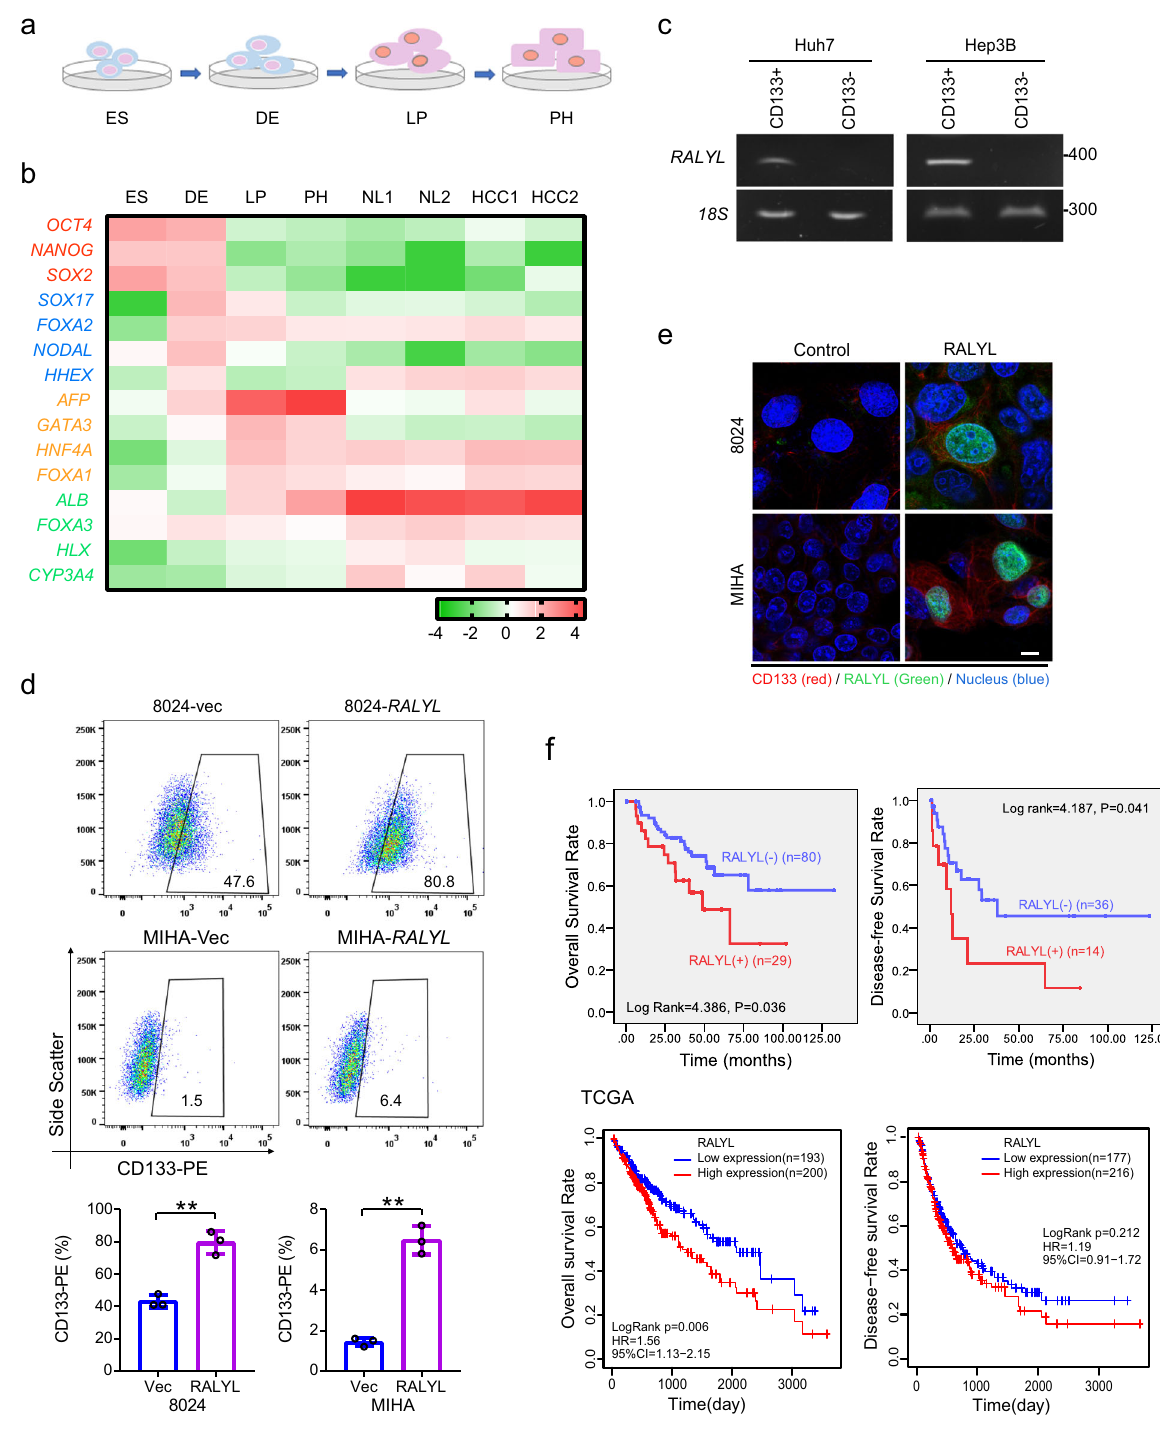
Fig. 1 RALYL selection and clinical signi fi cance. a An in vitro hepatocyte differentiation model, which induced human embryonic stem (ES) cells into de fi nitive endoderm (DE), liver progenitor cells (LP) and premature hepatocytes (PH) step by step, was established. Two HCC samples and two normal liver tissues (NL) were also used to perform the transcriptome sequencing. b Heatmap of expression pro fi les for the speci fi c markers for ES ( Oct4 , Nanog , and Sox2 ), DE ( Sox17 , FOXA2 , Nodal , and Hhex ), liver progenitor cells ( AFP , Gata3 , HNF4 α , and FOXA1 ), and hepatocyte ( Albumin , FOXA3 , Hlx , and Cyp3a4 ) shows the reliability of the hepatic differentiation model. The red represents a higher expression level, and the green represents a lower expression level. c RT-PCR analysis showed higher RALYL expression in CD133 + cells than in CD133 − cells, which was sorted by FACS from Huh7 or Hep3B cells. d The proportions of CD133 + cells in 8024-Vec/ RALYL and MIHA-Vec/ RALYL were assessed by fl ow cytometry and illustrated in bar chart. The values indicate the mean ± standard deviation (SD) of three independent experiments (** P < 0.01, Student t -test). e Representative images of double immuno fl uorescence staining of RALYL (green) and CD133 (red) in 8024-Vec/ RALYL and MIHA-Vec/ RALYL . DAPI (blue) was used for nuclei counterstaining. Scale bar = 10 μ m. f Kaplan – Meier overall survival curve and disease-free survival curve of two HCC groups in our in-house cohort or The Cancer Genome Atlas (TCGA) cohort: RALYL ( + ) (red), patients with RALYL expression; RALYL ( – ) (blue), patients without RALYL